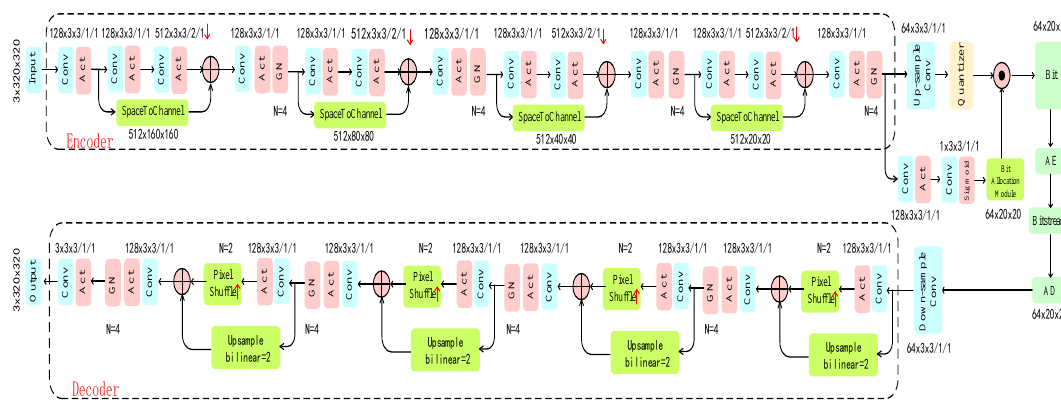
Figure 4. Illustration of the encoder and decoder. The blue box represents residual blocks for down-sampling or up-sampling, convolutional parameters are denoted as filter × kernel height × kernel width/stride/padding, the pink box represents group normalization (GN), activation function (Act), the yellow box is quantizer, the green box represents special operation module, and AE and AD represent arithmetic encoder and arithmetic decoder,